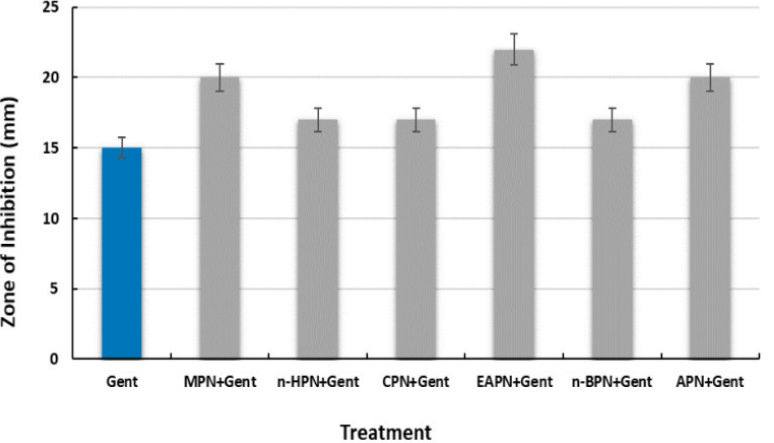
Figure 8. Antibiotic reversal activity of P. nigrum extracts in combination with gentamicin (10 μg) for S. aureus .